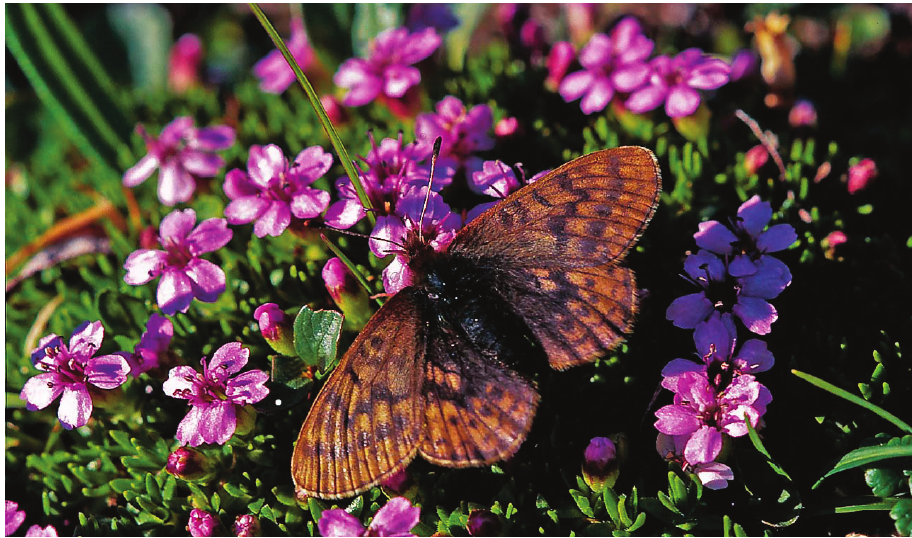
The species occurs usually in low densities in a restricted range in Northern